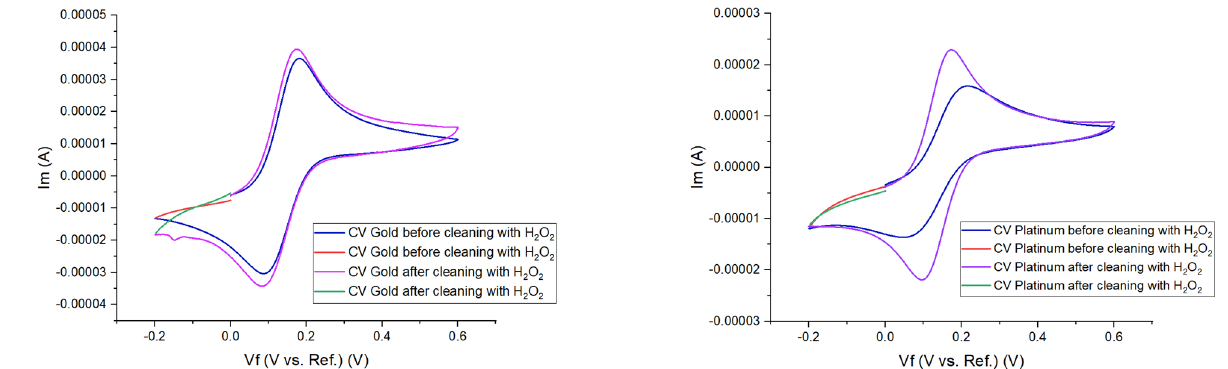
Figure 7. CV of the gold and platinum electrodes before and after cleaning with H 2 O 2 : blue/red-CV before cleaning; purple/green-CV after cleaning. Created with OriginPro.